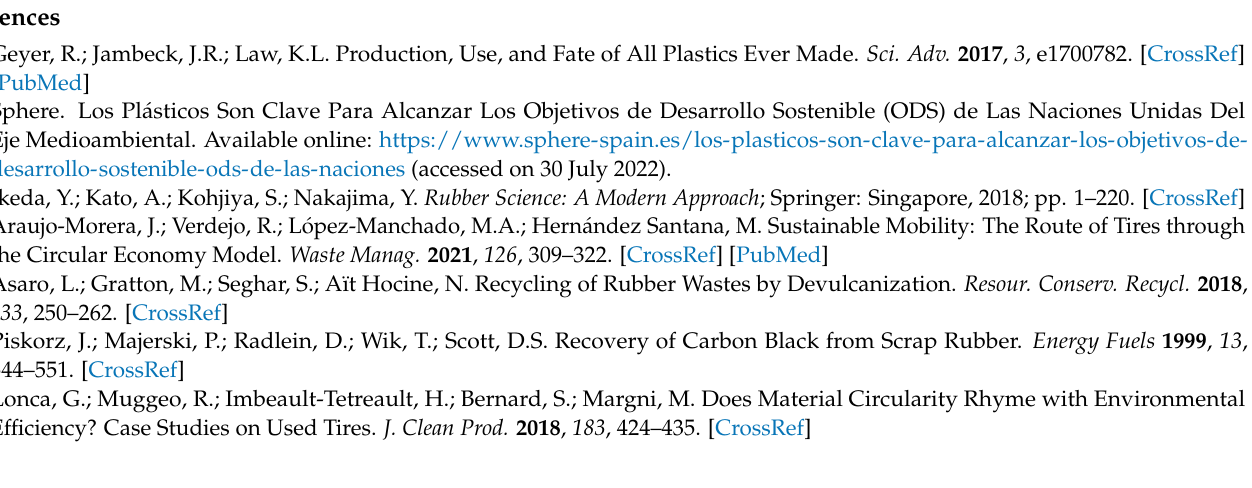
ric property values; Figure S2: DSC curves for pure matrix components and thermogravimetric curve for A; Figure S3: Stress–strain curves; Table S2: Mechanical property values; Figure S4: SEM photomi- crographs of selected Na-A and Ca-A TPEs; Figure S5: Temperature effect on self-healing